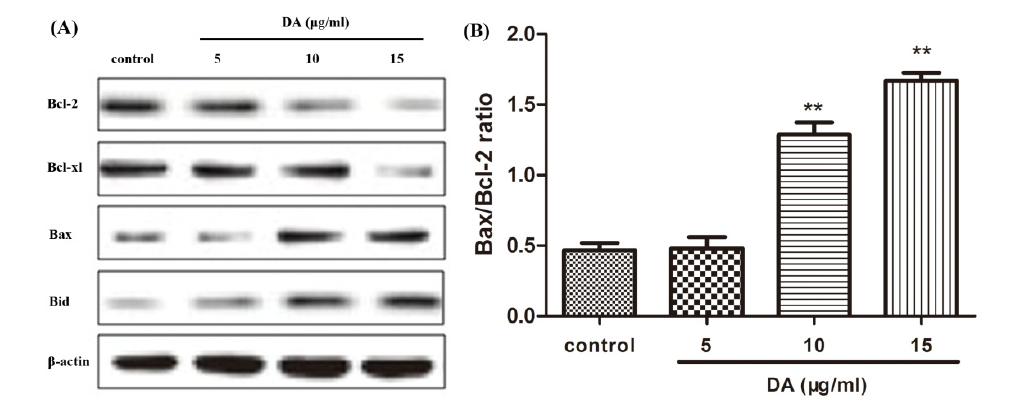
Figure 5. DA regulates Bcl-2 family protein expression. ( A ) Cells were treated with different doses of DA for 48 h. Bcl-2, Bcl-xl, Bax and Bid were determined by Western blotting using specific antibodies. ( B ) A densitometric analysis was used to quantify the levels of Bax and Bcl-2 to evaluate the effect of DA on the Bax/Bcl-2 ratio. All results were obtained from three independent experiments. * p < 0.05 and ** p < 0.01, compared with the